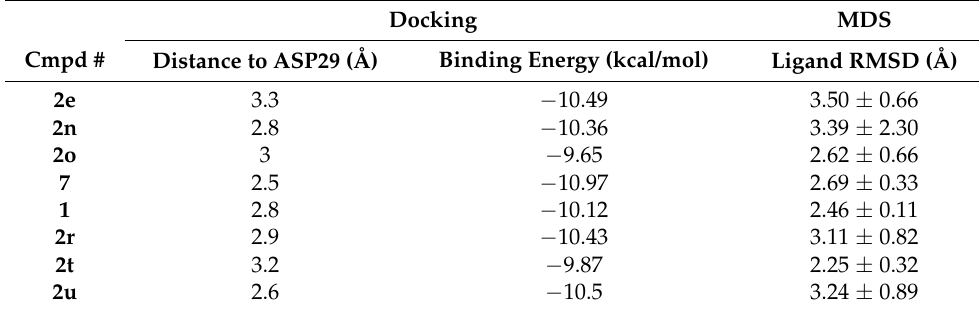
Table 3. Docking and MDS results of selected compounds. Docking MDS Cmpd